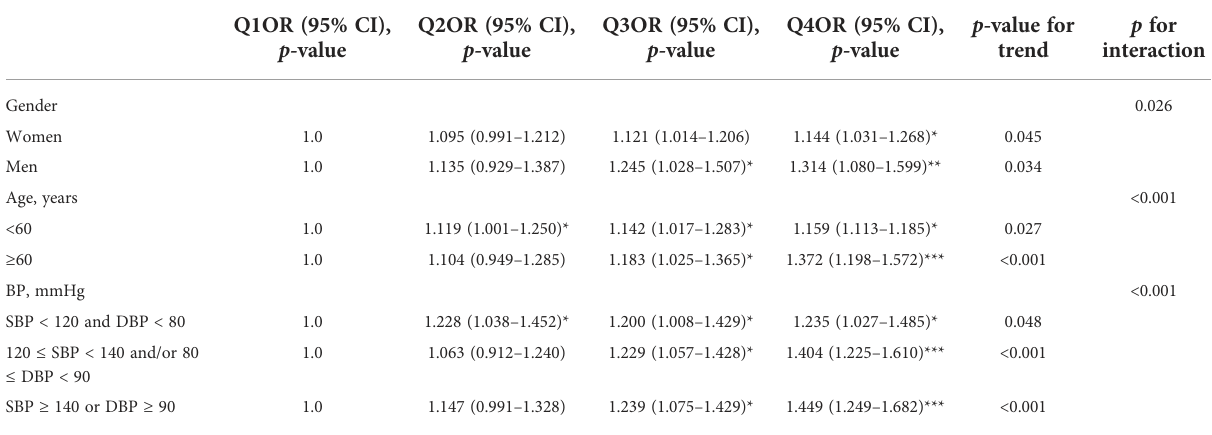
TABLE 3 Association between ABSI quartiles and UACR in different participants.